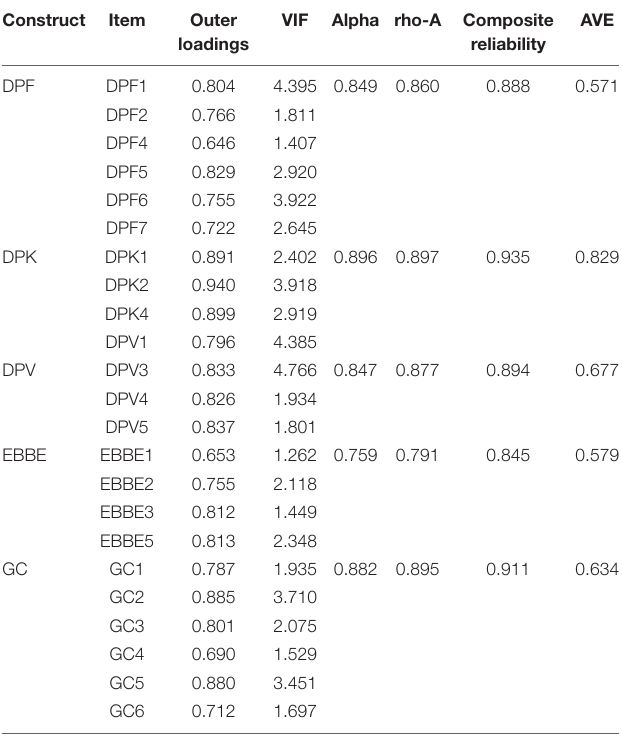
TABLE 1 | Reliability and convergent validity of the study constructs. Construct